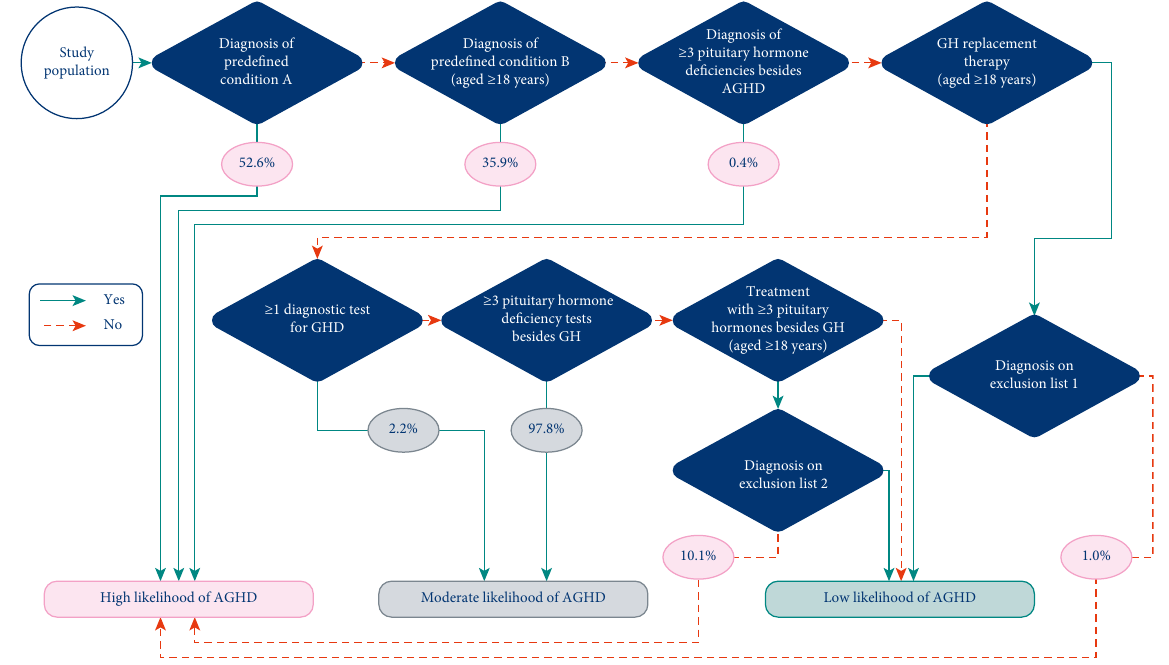
Figure 1: Schematic of a novel algorithm to categorize people by their likelihood of having AGHD using administrative claims data. The algorithm considered diagnosis codes, diagnostic tests, and treatments for each person in the study population. The flowchart consists of a number of guiding rules (diamonds), which result in the placement of each person into one of three groups by their likelihood of having AGHD. Each diamond is dependent on a set of codes (ICD10CM/ICD09CM for diagnoses, CPTfor tests, and ATC for treatments), which, combined with logical rules dependent on age, number of prescriptions, or diagnoses, were used to determine whether each person obeys the rule, as indicated by a green (yes) or dashed orange (no) arrow. AGHD, adult growth hormone deficiency; ATC, anatomical therapeutic chemical; CPT, current procedural terminology; GH, growth hormone; GHD, growth hormone deficiency; ICD09CM, International Classification of Diseases, ninth revision, Clinical Modification; ICD10CM, International Classification of Diseases, tenth revision, Clinical Table 1: Age and sex distribution of the study cohort overall and by the likelihood of having AGHD.